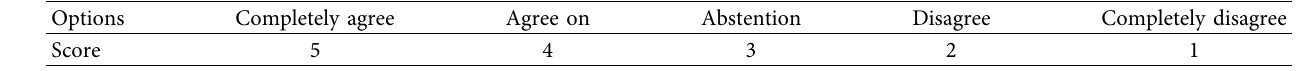
Table 2: Table of how to score each answer.